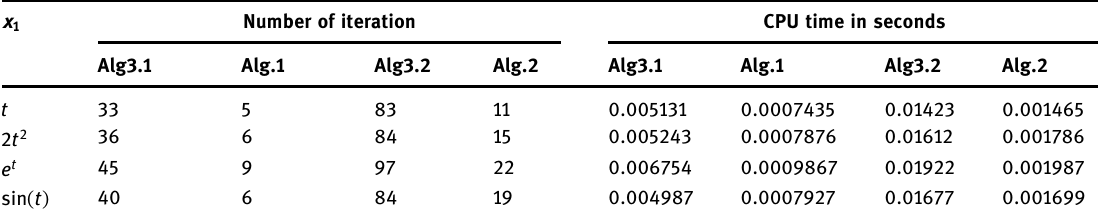
Table 3: Example 6.3: Algorithmic comparison of Algorithms 1 – 2 with Algorithms 3.1 – 3.2 in [ 31